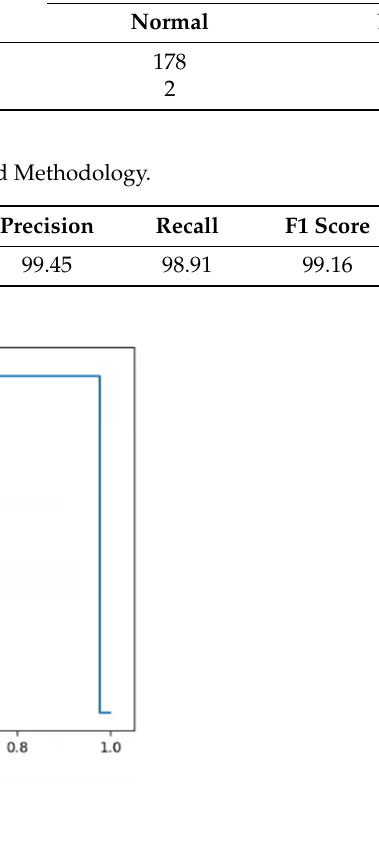
Table 4. Confusion Matrix for Image Classification.